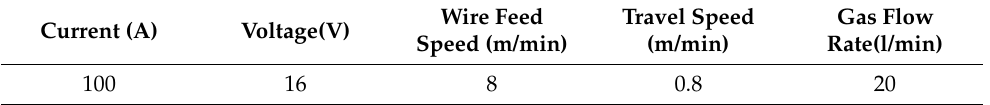
Table 2. Summary of the main processing parameters used for metal deposition by